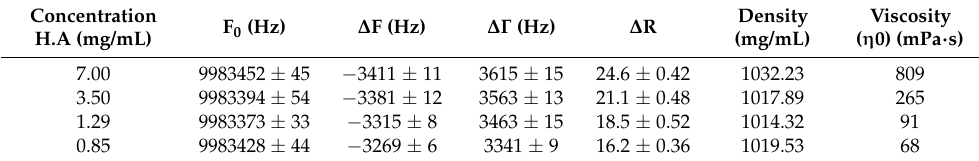
Table 3. Hyaluronic Acid (H.A) results (Average ± SD).